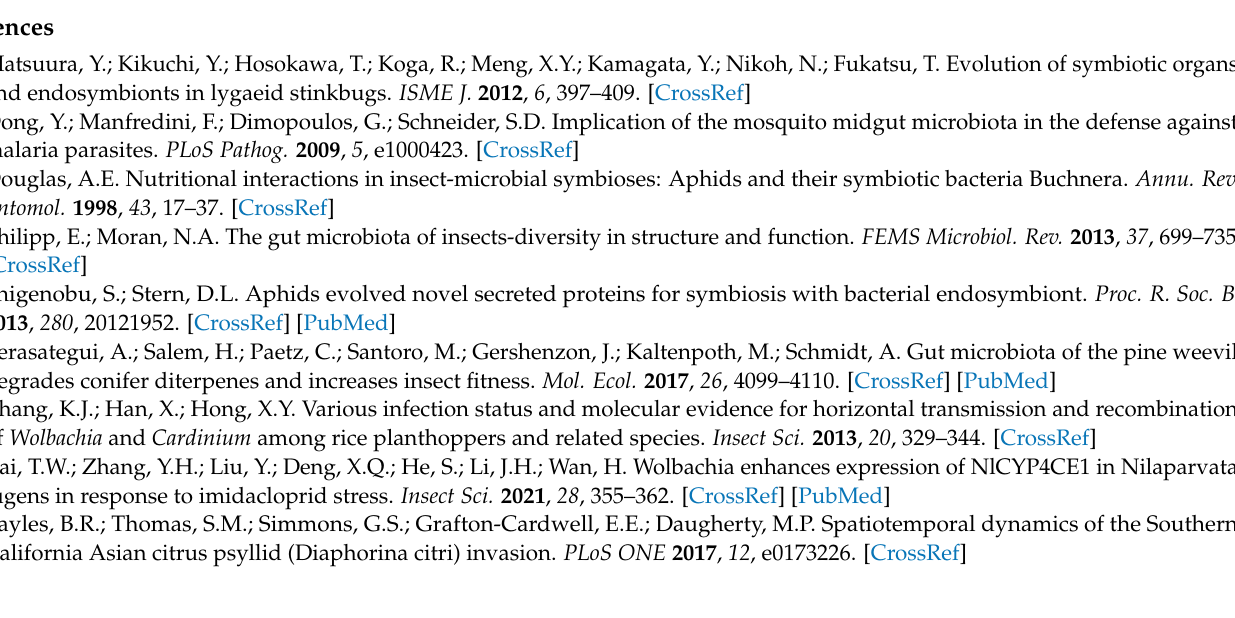
Table S2. Primer sequences used for quantitative real-time PCR; Table S3. Overview of 16S rRNA gene fragment sequencing dataset obtained with D . citri ; Table S4. Bacterial community composition (%) in D . citri at different taxonomic levels under different temperatures (only taxa with a relative abundance > 0.1% are shown); Table S5. Bacterial community composition in different samples of D . citri . Total counts are provided for different sample types at the specified taxonomic resolutions; Table S6. The bacterial community of D . citri at the different taxonomic level and their abundance in different temperature treatments; Table S7. The Wolbachia and Profftella proportion of male adults under the high and low-temperature treatments by Two-factor analyses; Table S8. The Wolbachia and Profftella proportion of male and females under the high-temperature treatments by Two-factor analyses; Figure S1. Comparison of the bacterial community dynamics with same-gender of D . citri in different temperature treatments; Figure S2. Comparison of the bacterial community dynamics of D . citri at the same temperature but different